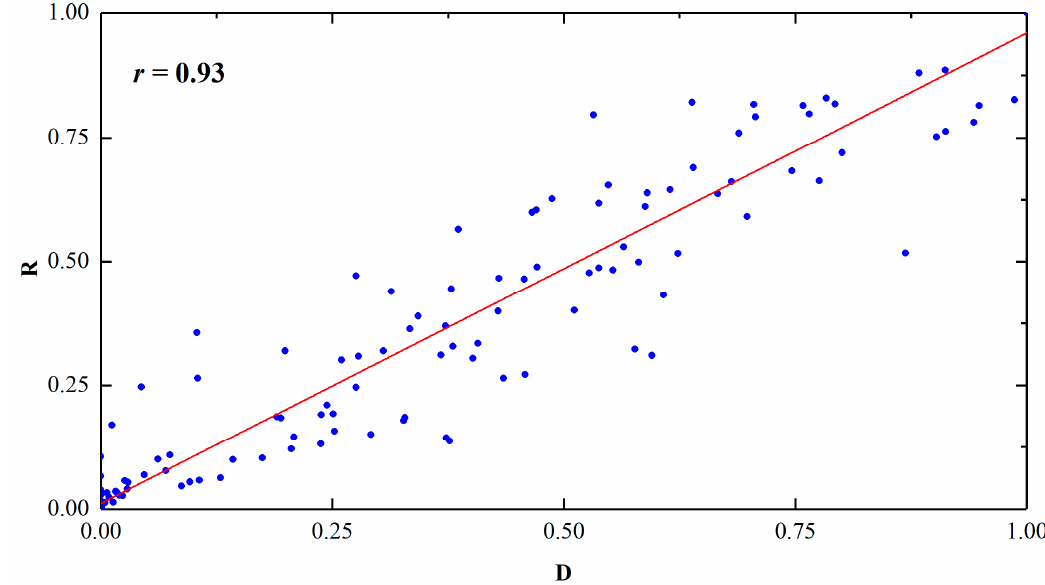
Figure 5. Scatter diagram of R and D under 28 earthquake waves.